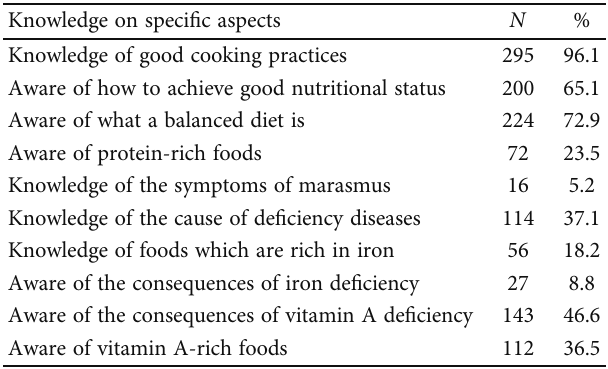
Table 6: Level of nutrition knowledge on various aspects of